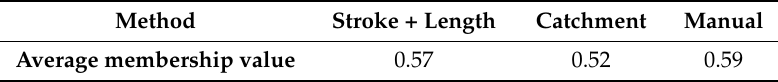
Table 11. Average membership value of preserved